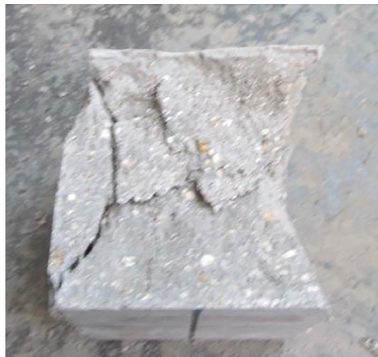
Figure 20: Destructive form of plain concrete.